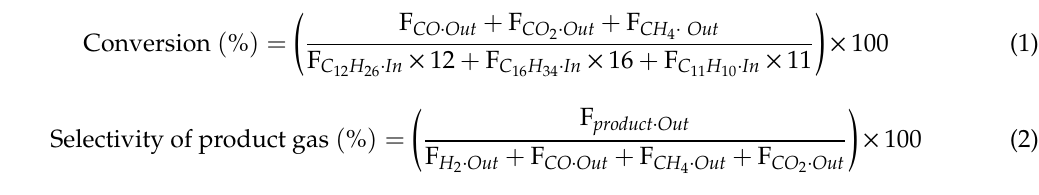
Figure S1: Conversions of the blank test, N10A, N30A, and N50A at DHM fuel, Figure S2 The schematic diagram of experimental